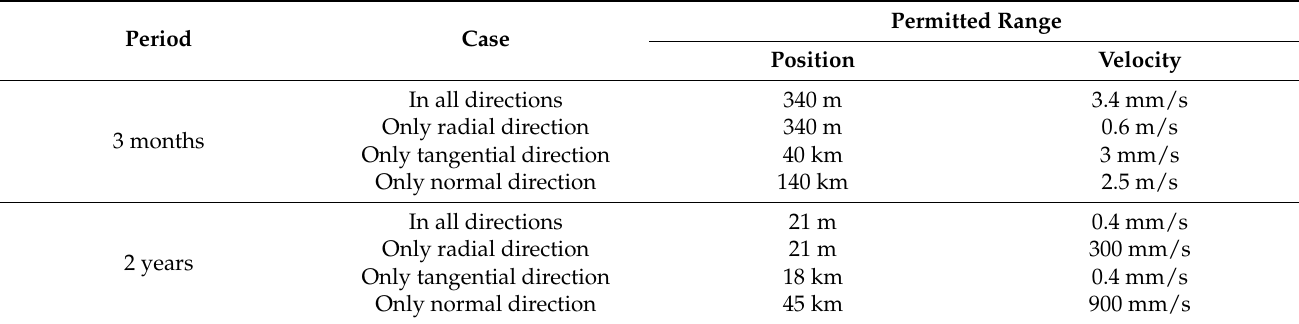
Table 9. Permitted ranges of the stability